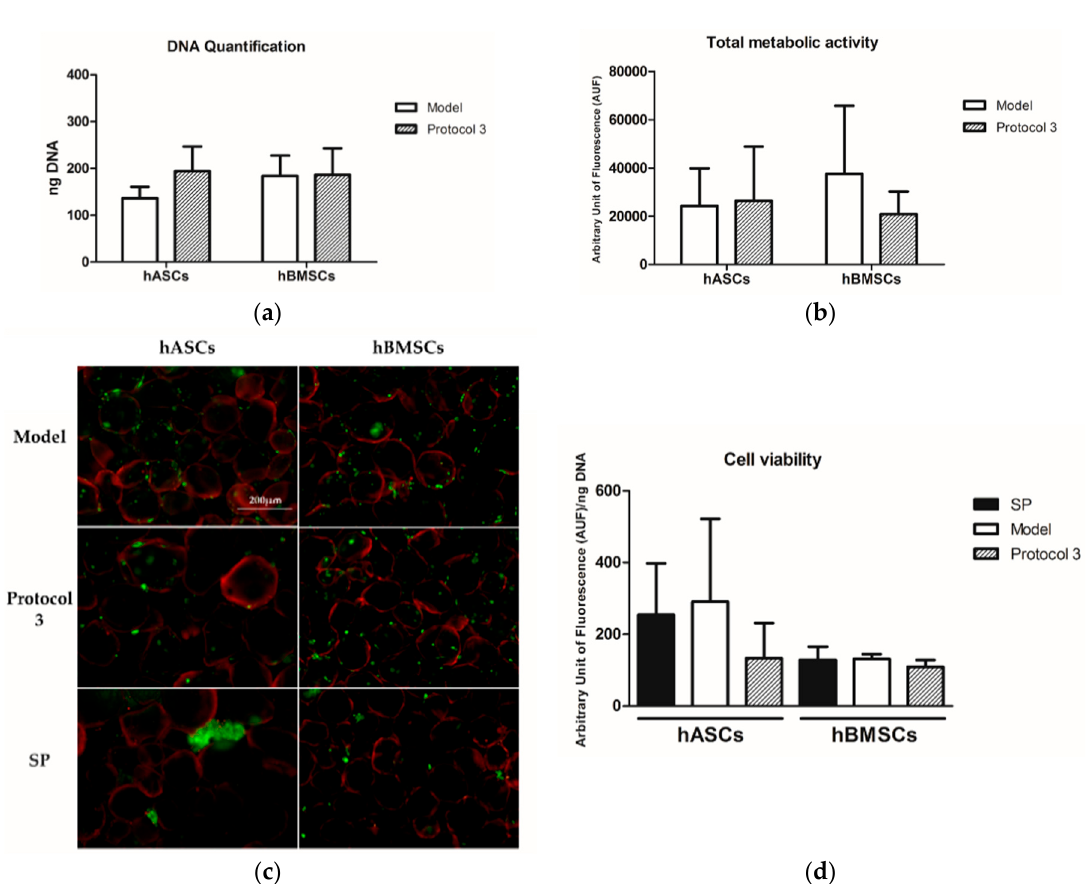
( a ) DNA quantification and ( b ) total metabolic activity of cells cultured with the DoE-predicted model ( model : 12.27 RPM, 98 min, intermittent, 401.5 µ L) and with protocol 3 ( 3 : 10 RPM, 60 min, intermittent, 400 µ L). Results are reported as mean ± SD. ( c ) Representative images of